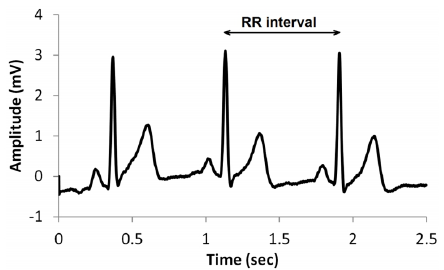
Figure 1. A typical electrocardiograph (ECG) signal showing the RR